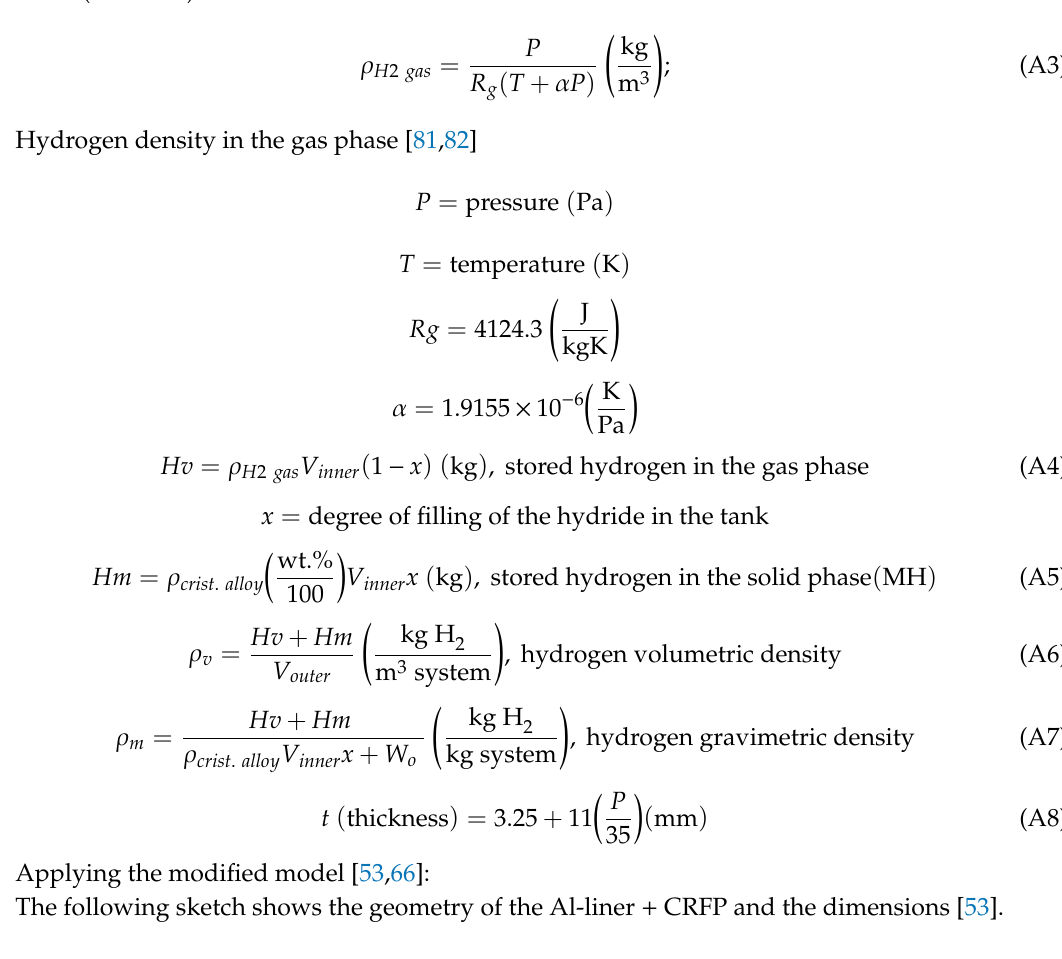
Table A5. Hydrogen volumetric and gravimetric density calculated with the model of Ge et al. 1.5